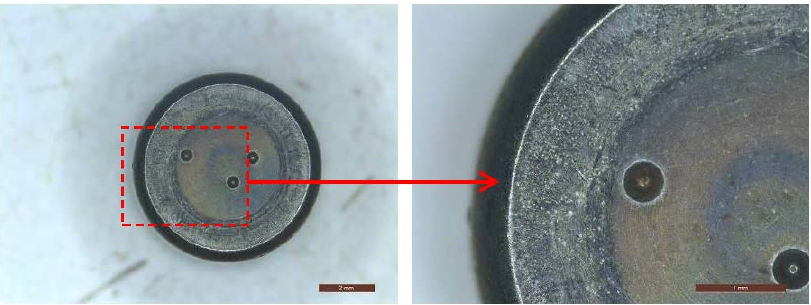
Figure 12. Damages of the roller end face, away from the bearing side with laser marking. The beams of six consecutive pockets (the pockets are numbered from No.1 to No.6),